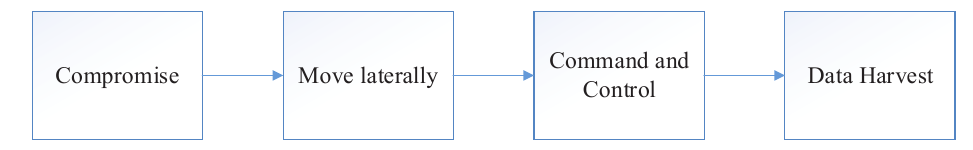
Figure 1. Advanced Persistent Threat (APT) attack